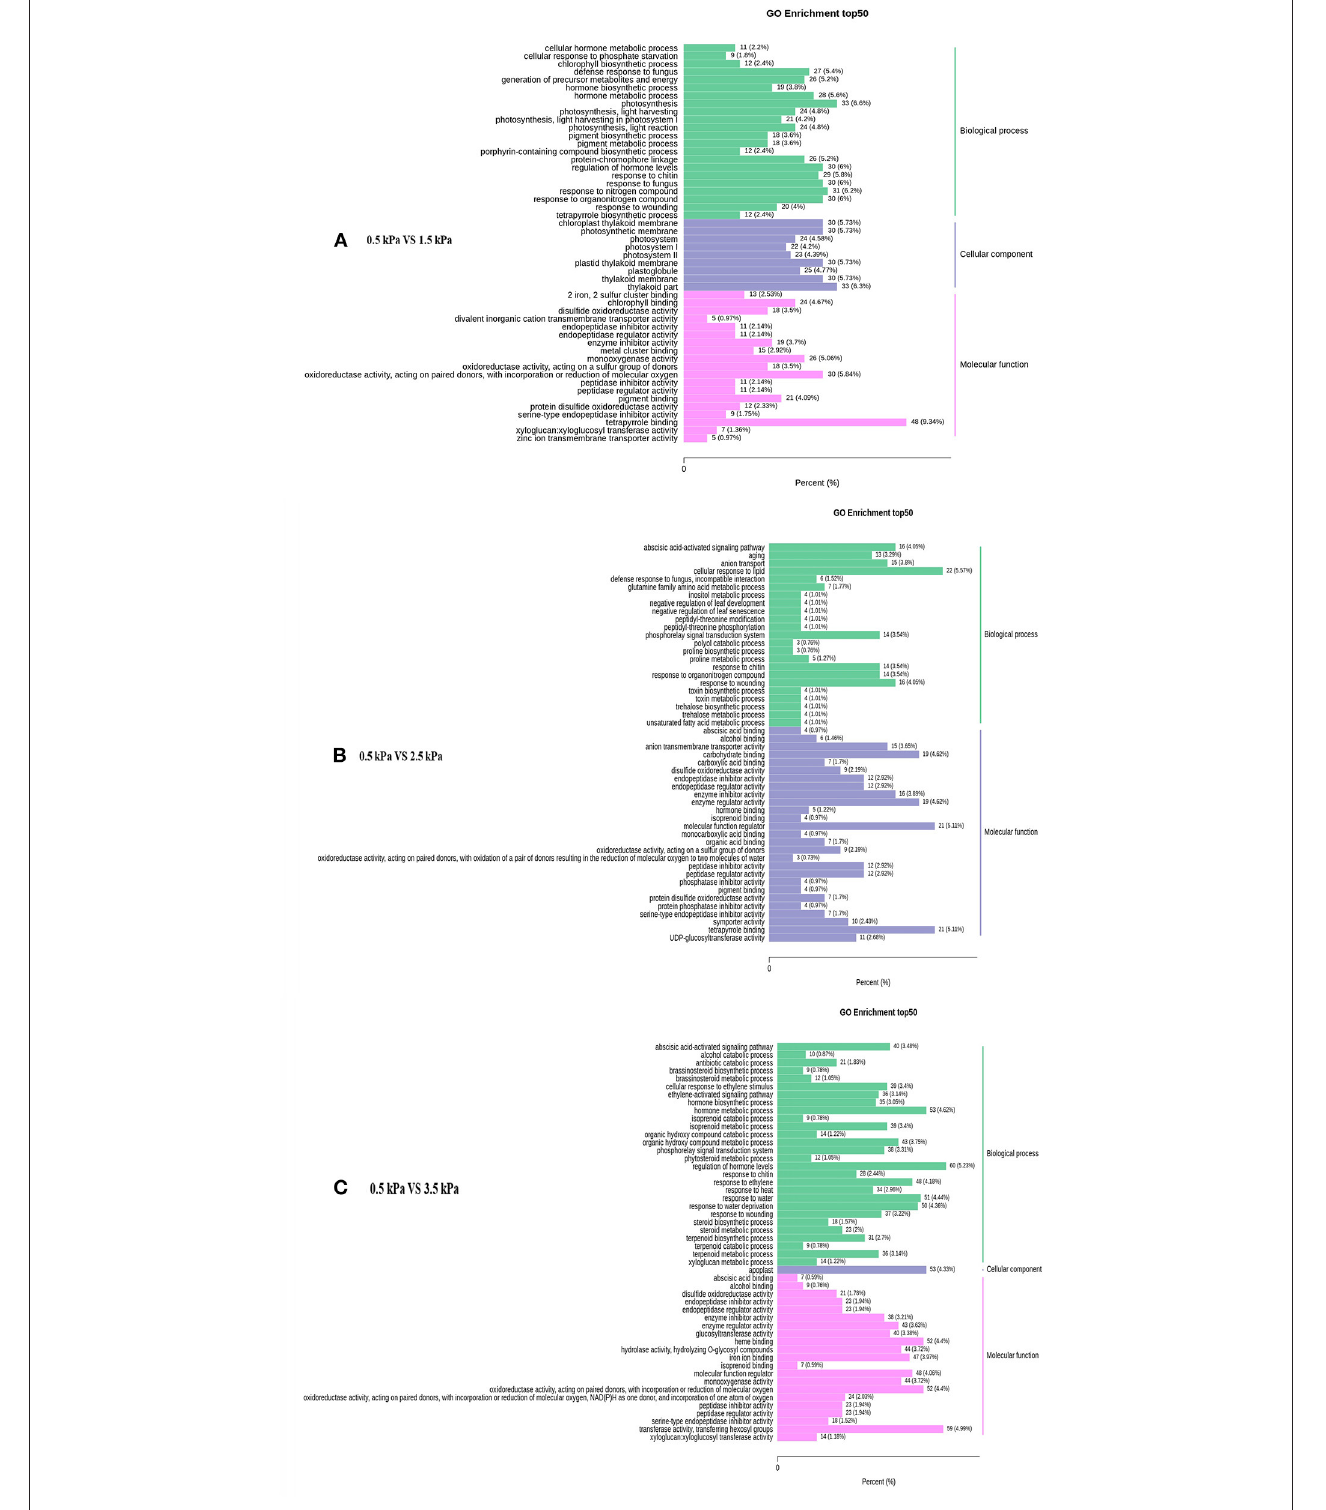
FIGURE 8 | Top 50 enriched GO terms of the differentially expressed genes under different VPD conditions: (A) 0.5kPa versus 1.5kPa; (B) 0.5kPa versus 2.5kPa; and (C) 0.5kPa versus 3.5kPa.